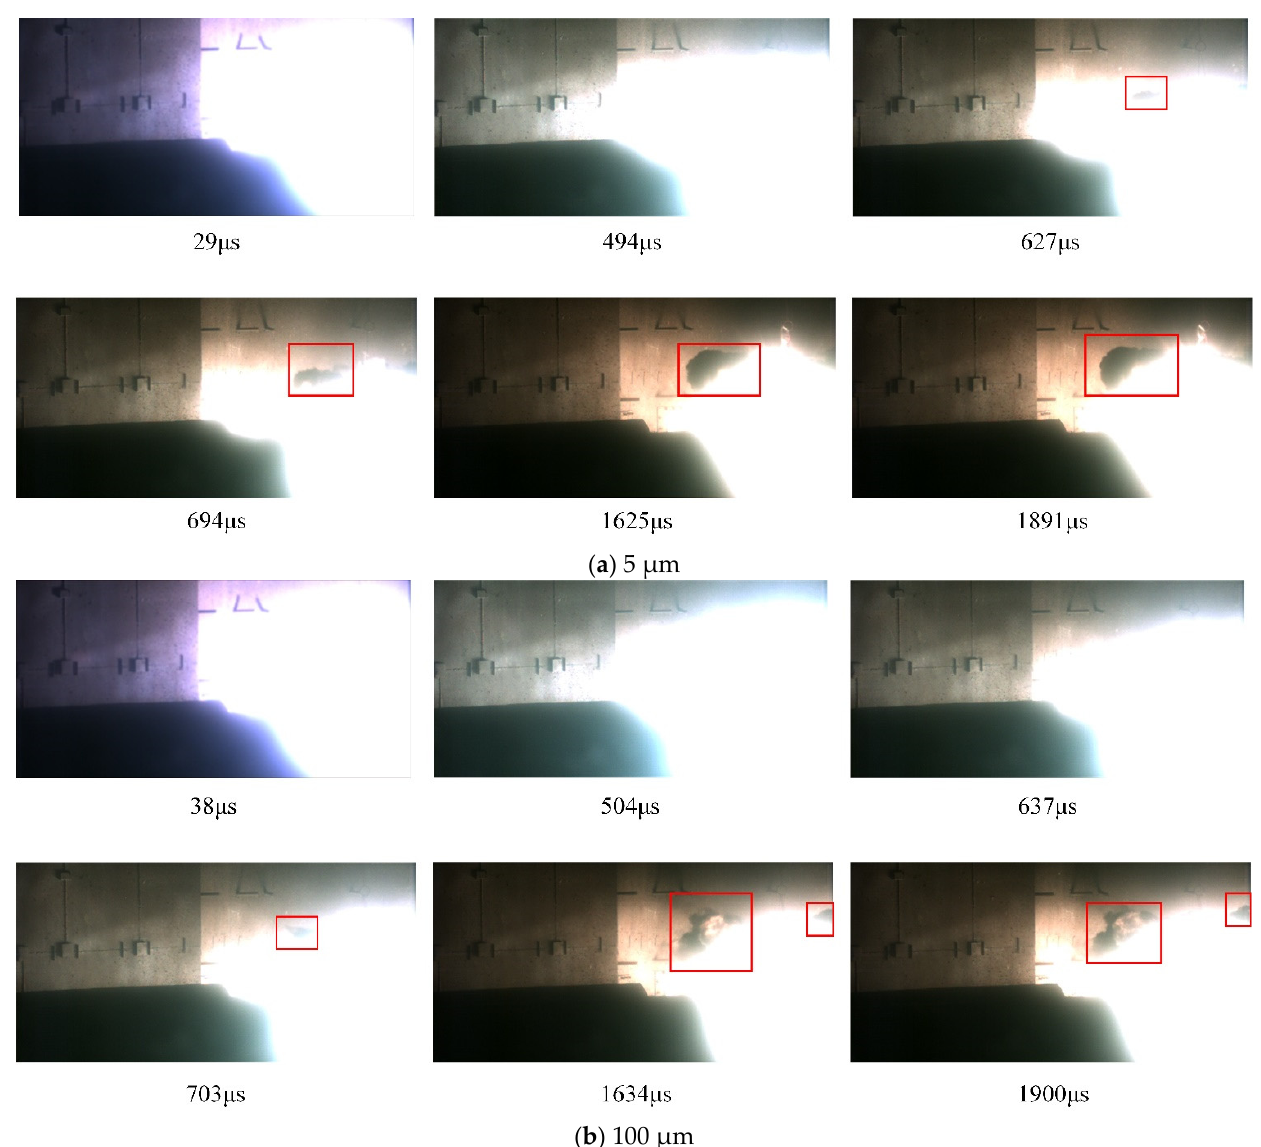
Figure 4. Energy release of RMs. (The red box refers to black smoke.).